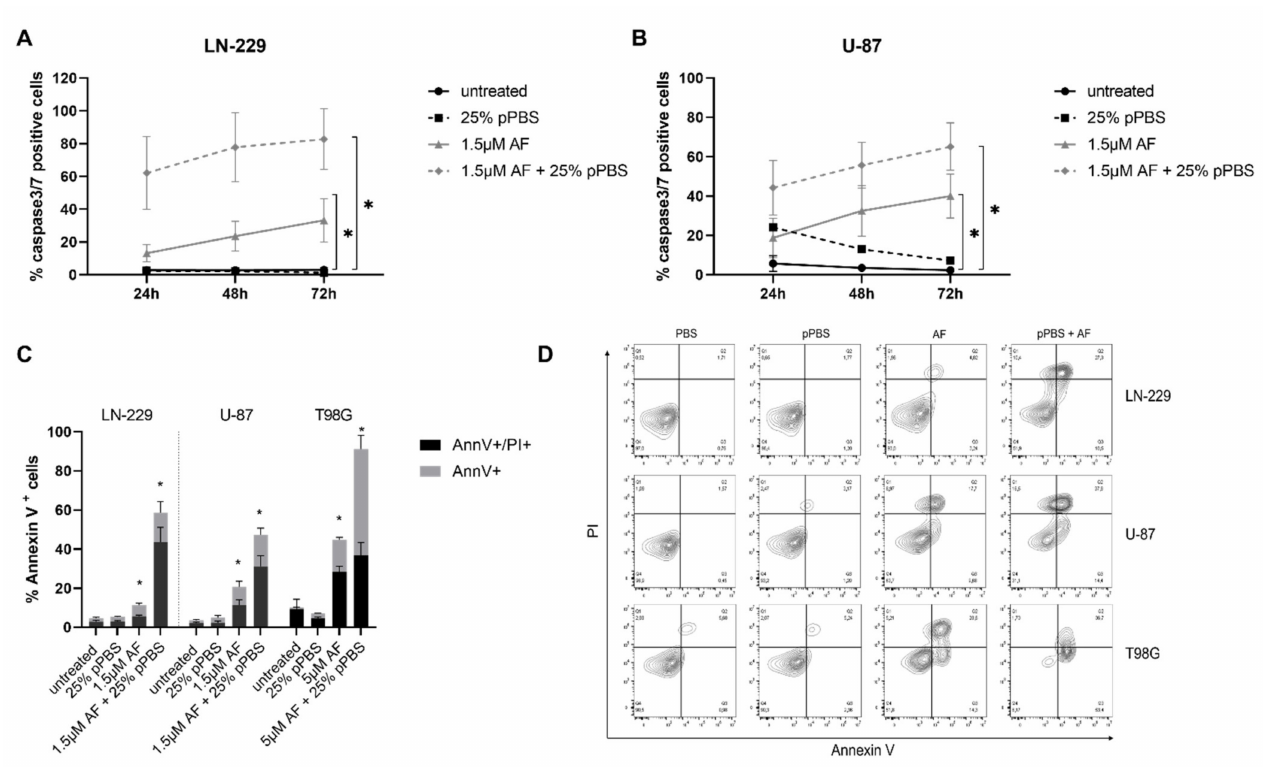
Figure 3. The combination treatment of AF and pPBS induces apoptotic cell death in GBM cell lines. ( A ) Percentage of caspase-3/7 green positive LN-229 cells after 24, 48 and 72 h of treatment. ( B ) Percentage of caspase-3/7 green positive U-87 cells after 24, 48 and 72 h of treatment. ( C ) Percentage of Annexin V+ cells after 48 h of treatment, subdivisions of AnnV+/PI- and AnnV+/PI+ are made. ( D ) Representative contour plots showing the flow cytometric analysis of Annexin V and PI staining after 48 h of treatment. Q1 = AnnV-/PI+, Q2 = AnnV+/PI+, Q3 = AnnV-/PI-, Q3 = AnnV+/PI-. Graphs represent mean ± SEM of ≥ 3 independent experiments. * p ≤ 0.05 denotes a statistically significant difference compared with untreated